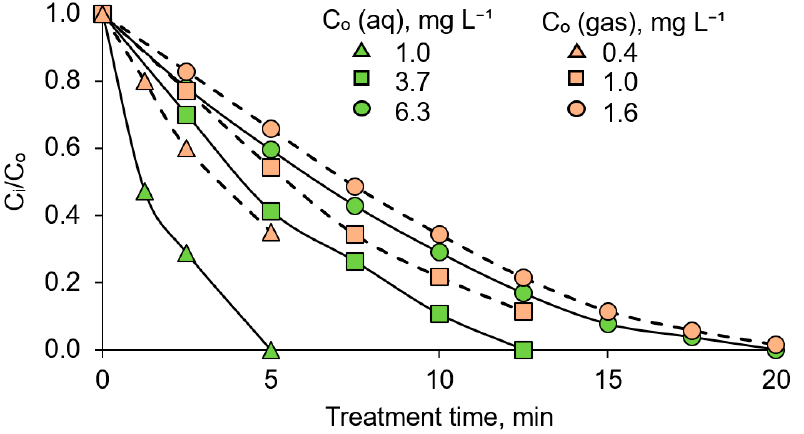
Figure 2. Simultaneous toluene PCD oxidation in aqueous and gaseous phases depending on treat-